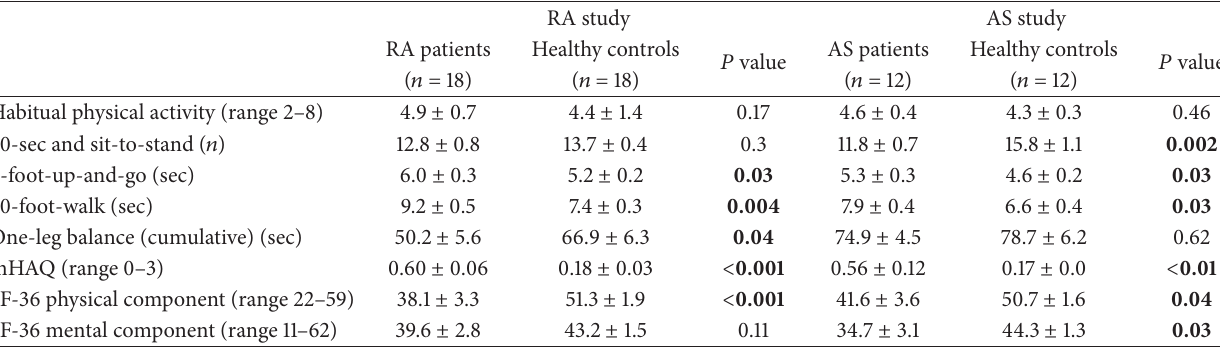
Table 2: Habitual physical activity and subjective and objective physical function. Presented are the results (mean ± SEM) of RA ( 𝑛 = 18 ; 13 women) and AS ( 𝑛 = 12 ; 4 women) patients and their respective age- and sex-matched healthy controls.